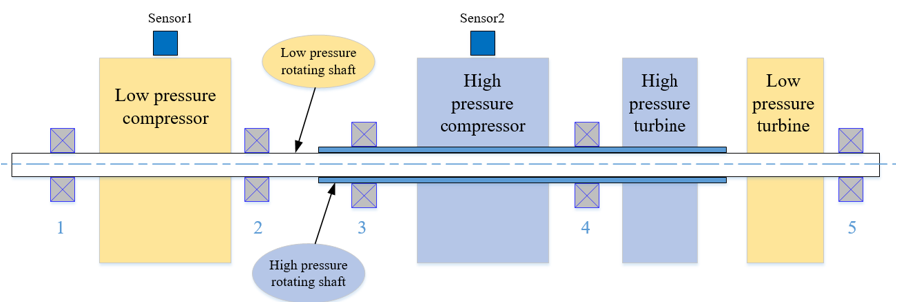
Figure 15. Structure of a certain type of gas turbine rotor system. ( 1 ) ball bearing for low pressure compressor; ( 2 ) cylindrical roller bearing for low pressure compressor; ( 3 ) ball bearing for high pressure compressor; ( 4 ) cylindrical roller bearing for high pressure compressor; ( 5 ) cylindrical roller bearing for low pressure turbine.